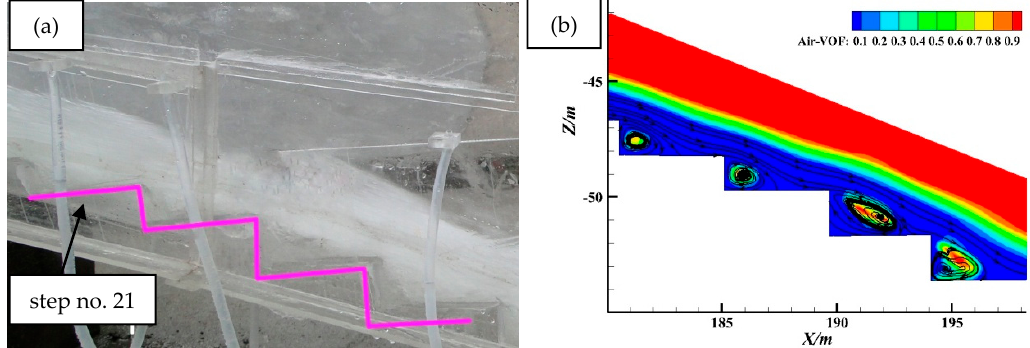
Figure 11. Flow pattern on the steps. ( a ) The experimental measurement results; and ( b ) numerical